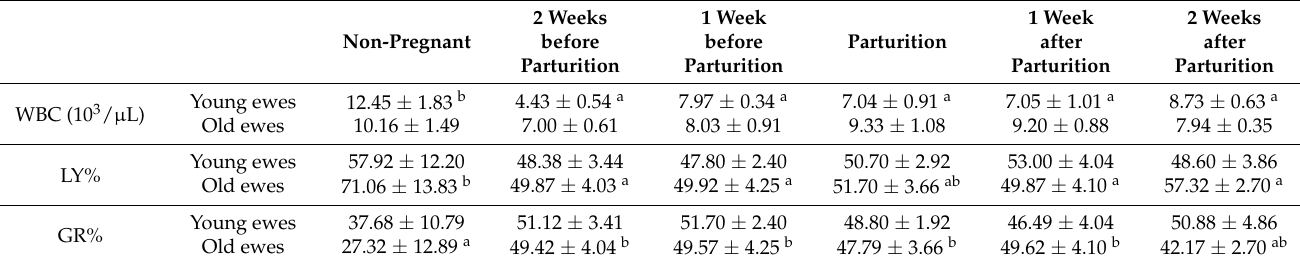
Table 3. White blood cell parameters in the blood plasma of ewes ( n = 18). Non-Pregnant